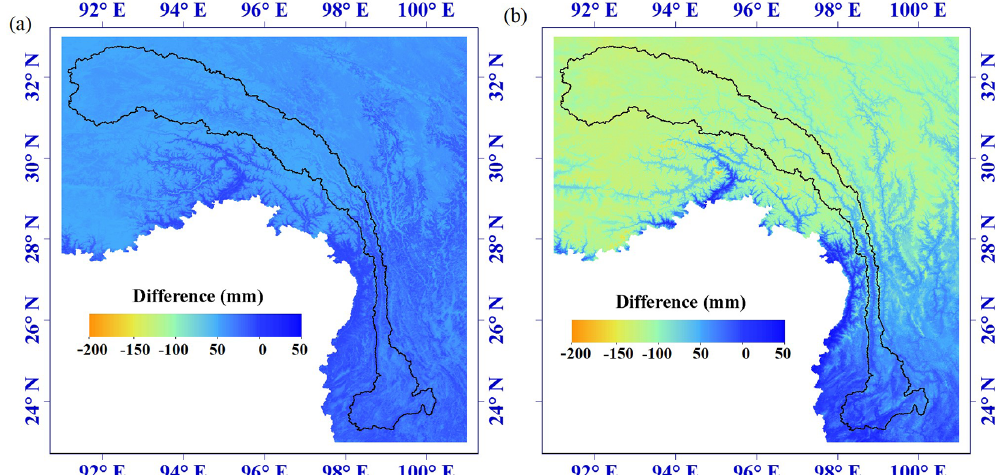
Figure 15. Spatial precipitation difference between RME and (a) RME + H ; (b) RME + T (b) .